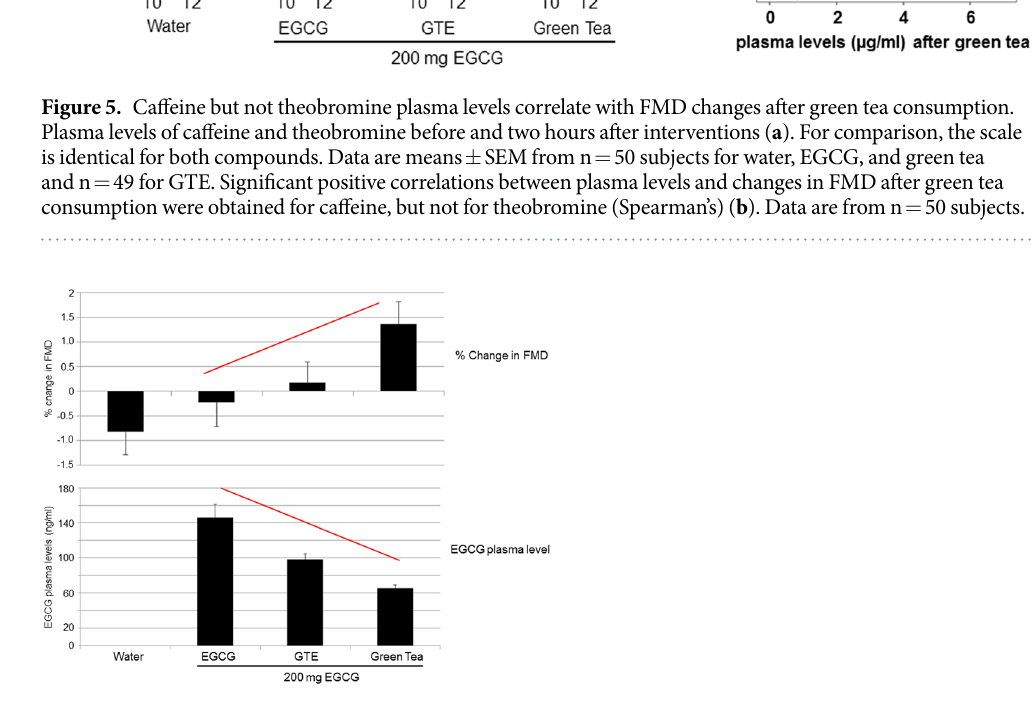
Figure 6. Inverse relationship between FMD and EGCG plasma levels after the interventions. FMD gradually increased with the number of compounds present (i.e., with the complexity) of the intervention (upper panel), but EGCG plasma levels are inversely